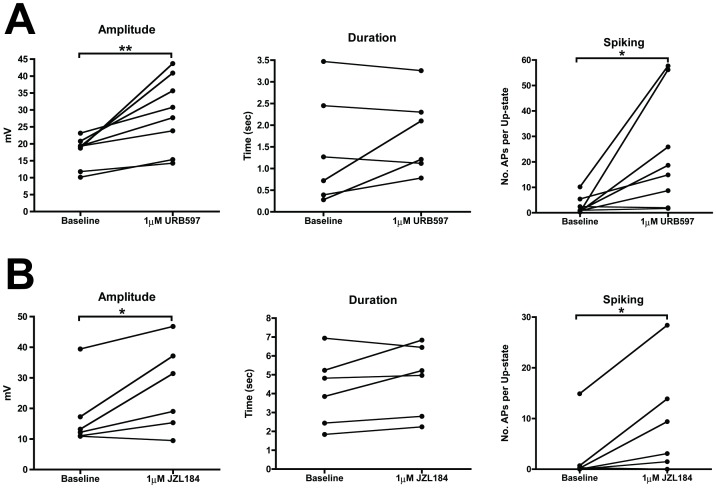
Selectively increasing either AEA or 2-AG by inhibiting FAAH or MAGL, respectively, increases up-state amplitude and spiking.A, effect of FAAH inhibition with URB597 (1 µM) on up-state parameters. B, effect of MAGL inhibition with JZL184 (1 µM) on up-state parameters. Connected points represent data from the same the cell during baseline and in the presence of the drug. Symbols: *p<0.05 and **p<0.01.